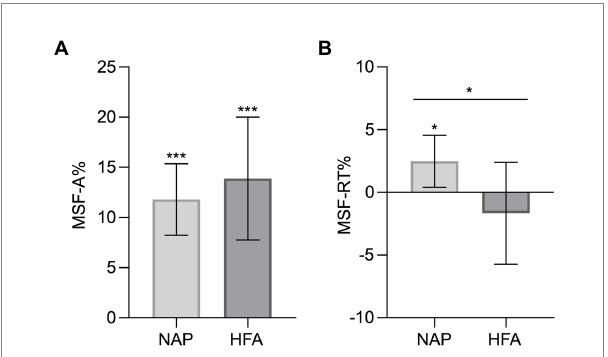
FIGURE 2 Multisensory facilitation (MSF) of accuracy (A) and of response time (B) showing a significant difference between NAP and HFA for the MSF of response time. Error bars represent the corresponding 95%- CI. MSF-A%, Multisensory facilitation of accuracy (percent improvement); MSF-RT%, Multisensory facilitation of response time (percent reduction); NAP, non-autistic people; HFA, high-functioning autism. * p < 0.05. ** p < 0.01. *** p < 0.001.